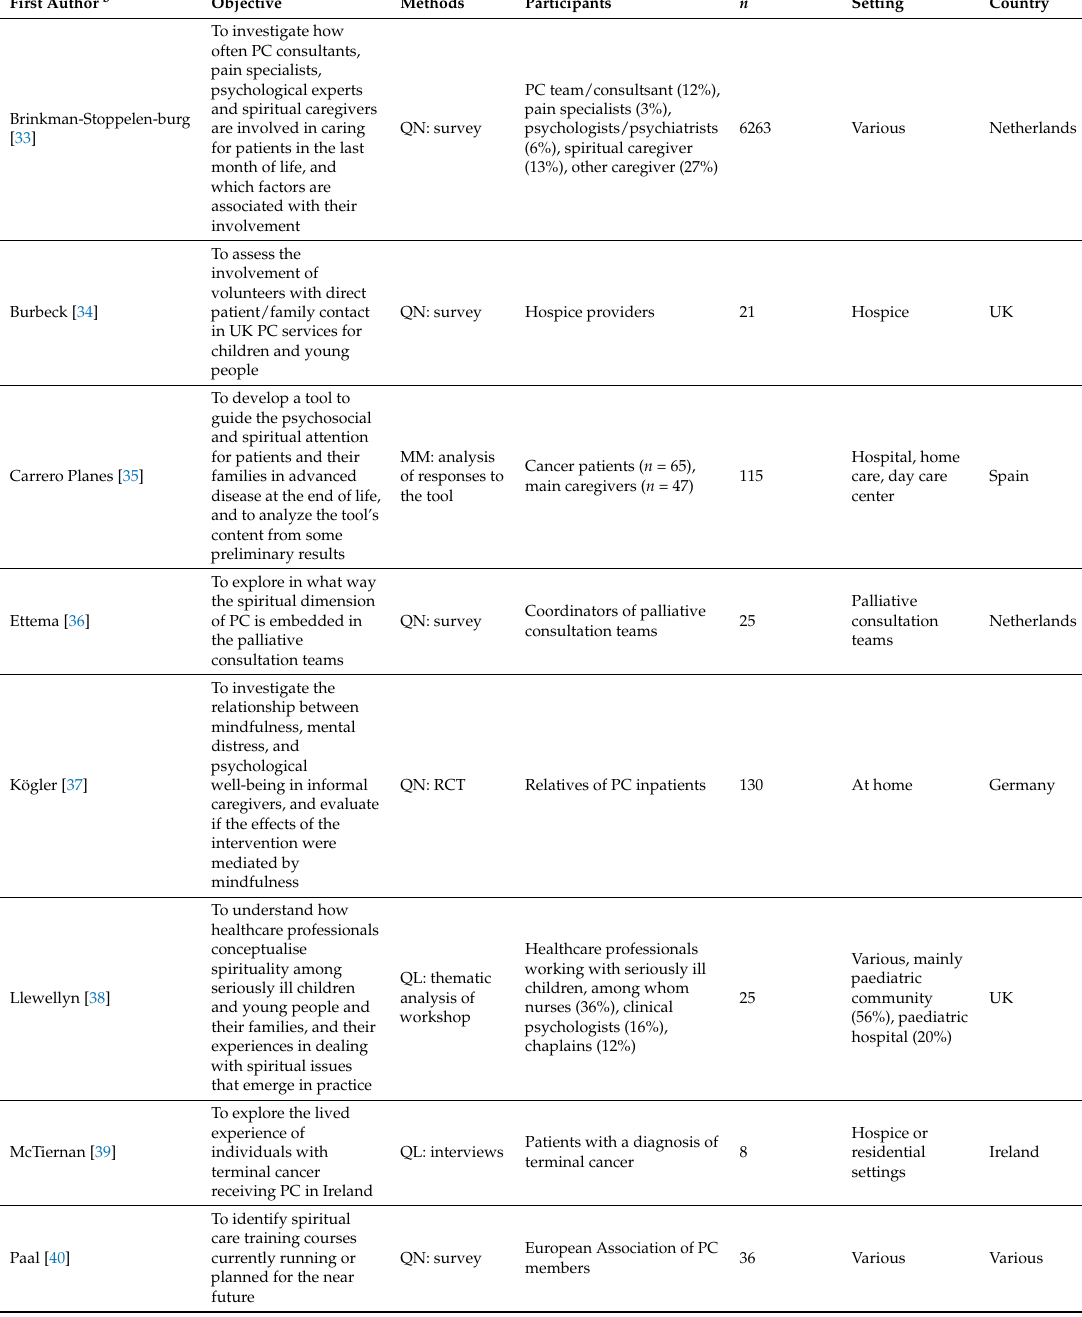
Table 1. Characteristics of the included articles a